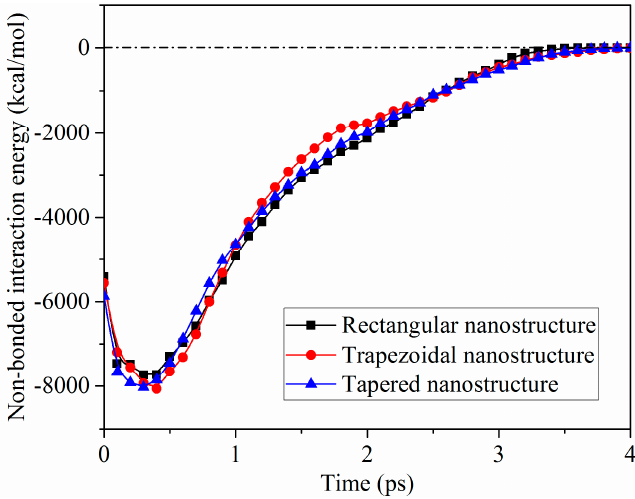
Figure 3. Non-bonded interaction energies of the three contact interfaces.